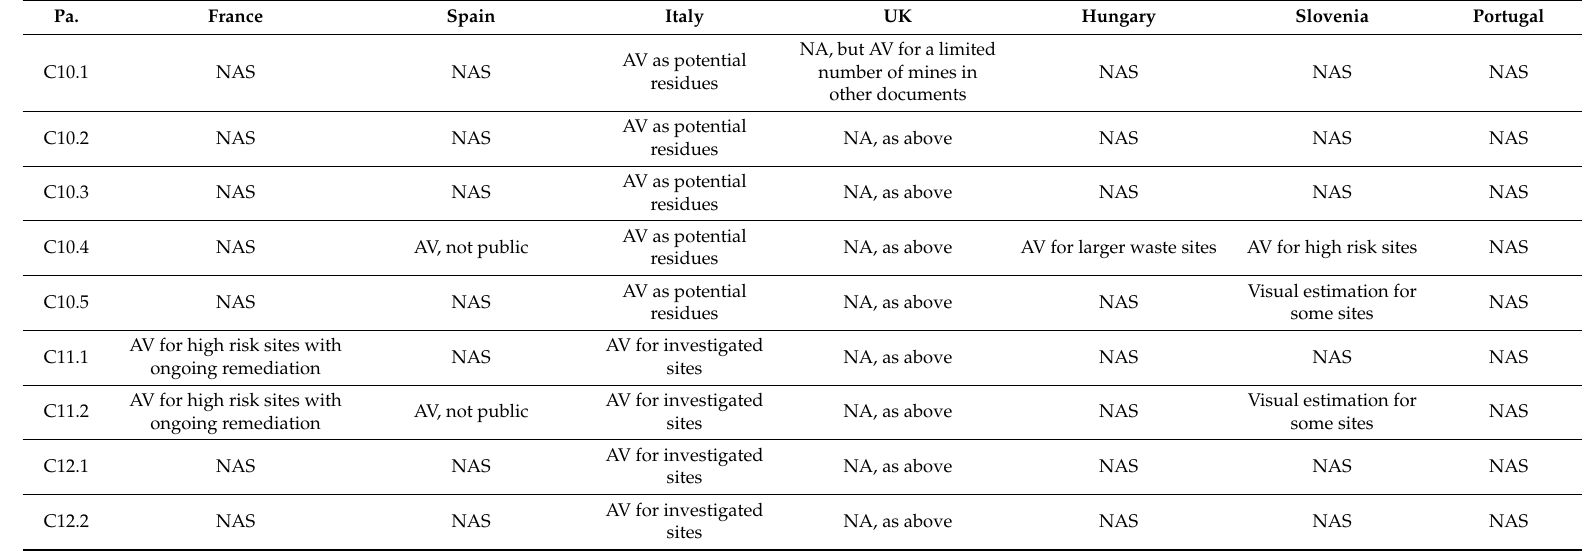
Table 5. Key “material-centric” valorisation parameters—data availability in di ff erent EU countries (AV—Available, NA—Not Available, NAS—Not Assessed).